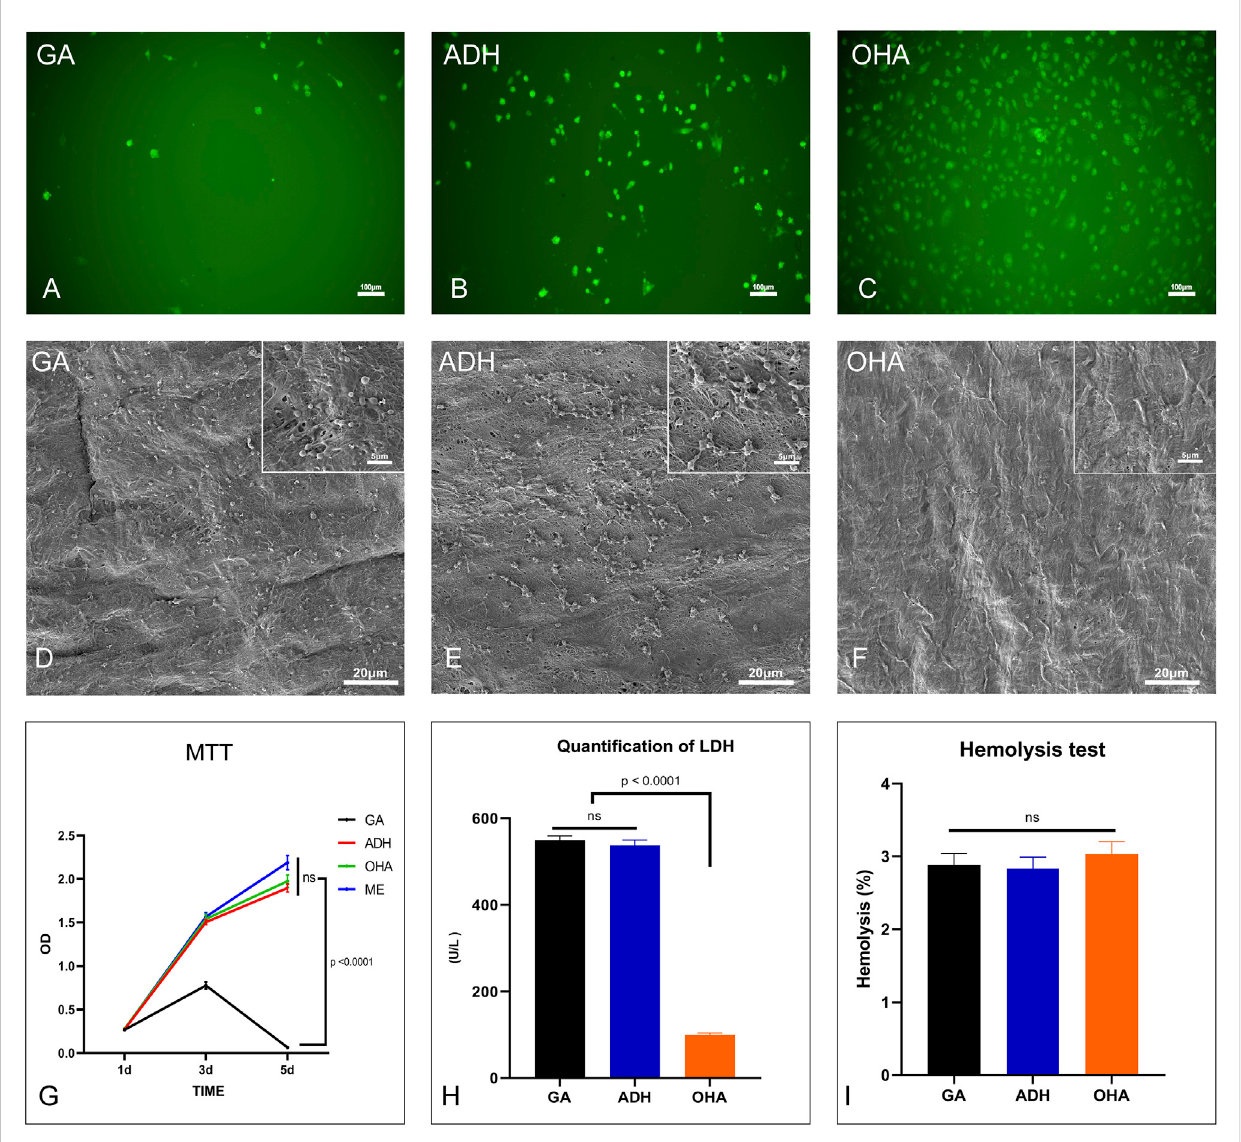
FIGURE 6 The cytocompatibility and hemocompatibility of the three groups. Human umbilical vein endothelial cell (HUVEC) proliferation and morphology were assessed by 6-CDCFDA live cell fl uorescent staining. HUVECs almost completely covered the surfaces in the OHA group (C) on day 5, while only a few cells were present on the surfaces in the GA and ADH groups (A, B) . The cytotoxicity of the lea fl ets was determined by MTT assay, and the relative growth ratios of the GA group were signi fi cantly lower than those of the ADH and OHA groups (G) . Platelet adhesion on the surface of the samples was evaluated by SEM imaging (D – F) and LDH assay (H) . LDH levels in the OHA group were signi fi cantly lower than those in the GA and ADH groups. There was no signi fi cant difference in the hemolysis rate among the three groups (I)